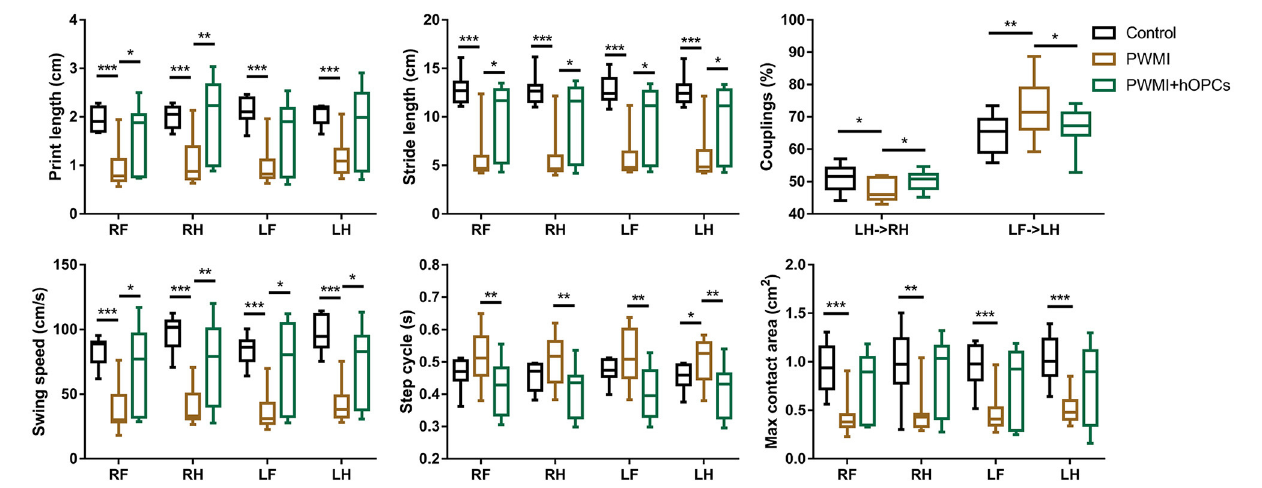
FIGURE 5 | Gait analysis between groups. HI injury-induced severe alternation in print length, stride length swing speed and max contact area of each paw, as well as coupling parameters LH- > RH and LF- > LH. Such alternation of gait parameters was improved following hOPCs-transplantation ( n = 10 for controls, n = 13 for PWMI and n = 12 for PWMI + hOPCs; Kruskal–Wallis non-parametric test with Mann-Whitney U -test for multiple comparisons). Data are presented as median (IQR); * P < 0.05, ** P < 0.01, *** P < 0.001.